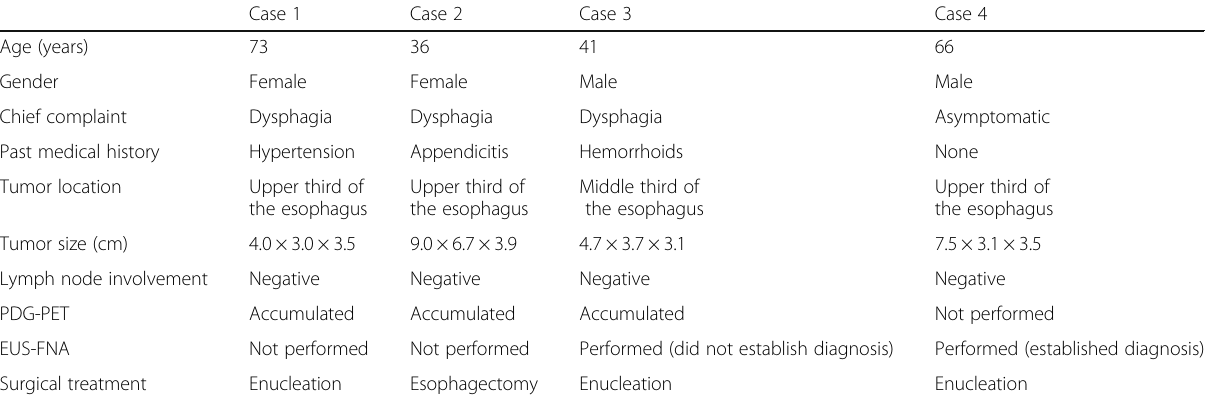
Table 1 Characteristics of the patient series with esophageal